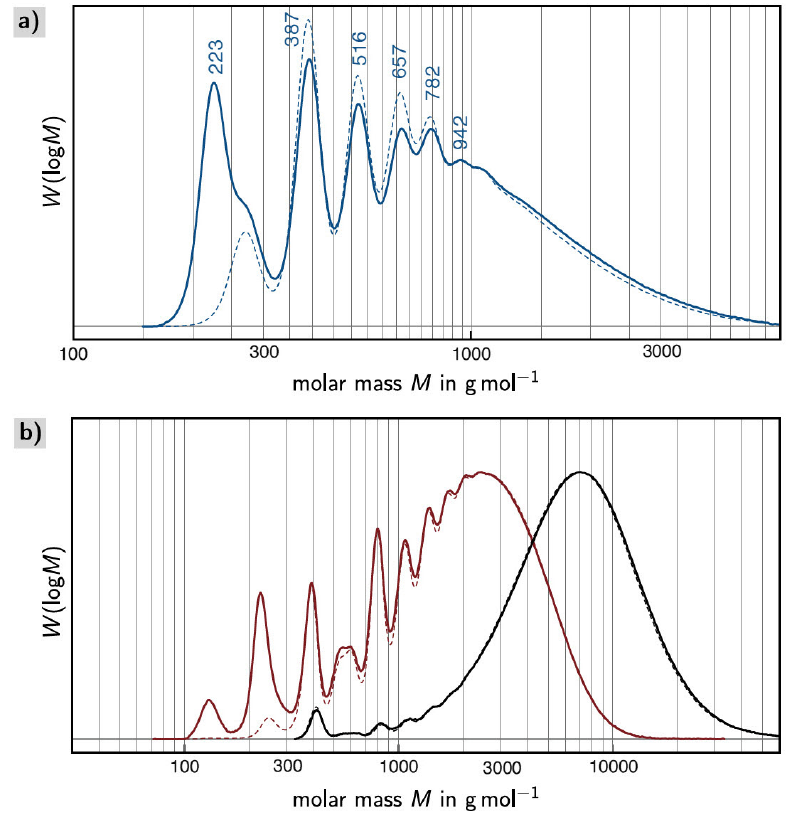
Figure 2. ( a ) SEC curve (solid line: RI signal, dashed line: UV signal) of the polyfunctional RAFT agent A ; ( b ) SEC curves (solid lines: RI signal, dashed lines: UV signal) of the polyfunctional RAFT agents C (red, obtained by rinsing with CS rinsing with